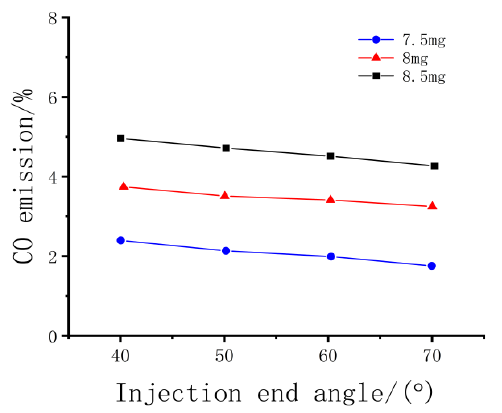
Figure 41. Effect of the injection parameters on CO emissions.